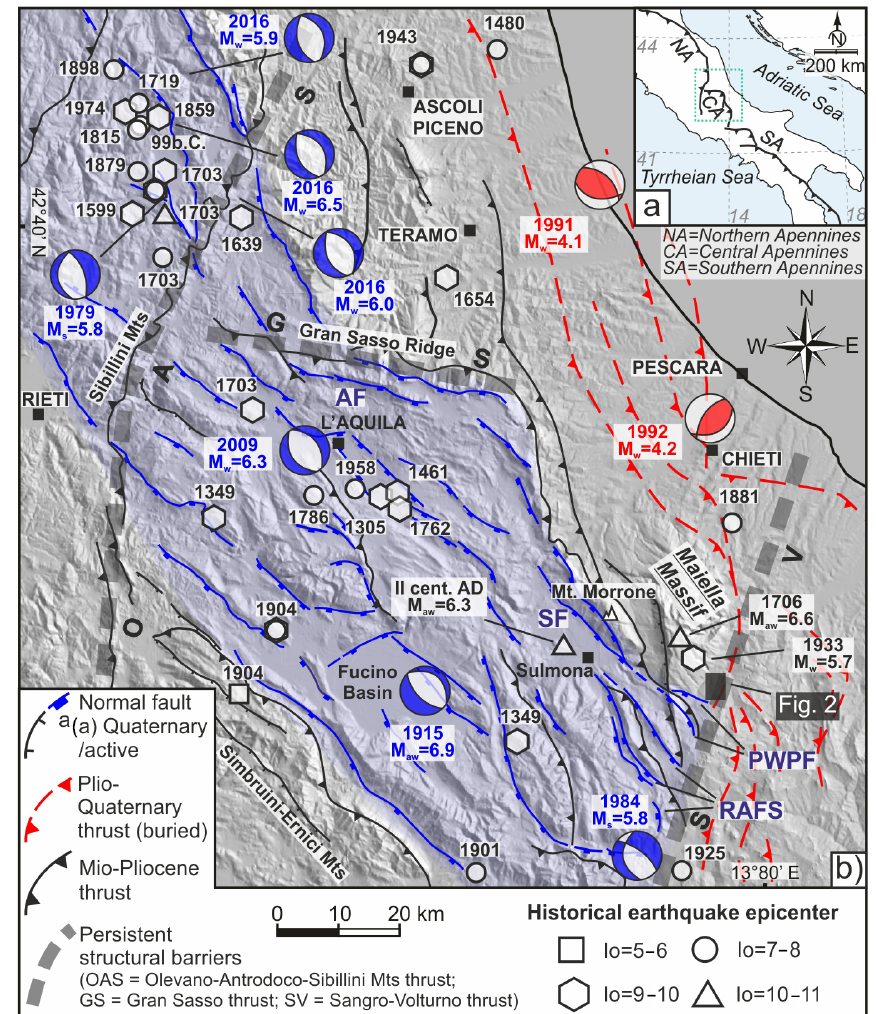
Figure 1. (a) The three major arcs of the Apennine Neogene chain. (b) Simplified structural map of the Central Apennines and related seismicity (modified from Pizzi et al., 2010; de Nardis et al., 2011). Within the axial zone of the chain major Quaternary/active post-orogenic normal faults, superposed onto the Neogene thrusts, define the intra-Apennine extensional domain (light-blue band). Contractional or strike- slip tectonics prevail in the Adriatic foreland area, to the east. Epicenter location and macroseismic intensity (Io), or equivalent moment magnitude ( M aw ) and moment magnitude ( M w ), of historical and recent earthquakes (Working Group CPTI, 2004; Rovida et al., 2011 and Ceccaroni et al., 2009 for the 2nd century AD earthquake) indicate stronger seismicity within the inner extensional domain and only moderate events in the outer contractional zone. Some events, such as those in 1706 and 1933, localized in the Maiella Massif (i.e., at the extension/contraction transitional domain), still have an uncertain source and kinematics. Persistent structural barriers (dotted grey bands), oblique to the main trend of the normal fault systems, control the propagation and segmentation of the Quaternary/active normal faults (Pizzi and Galadini, 2009). AF: Assergi Fault; SF: Sulmona Fault; PWPF: Palena–western Porrara fault system; RAFS: Rotella–Aremogna fault